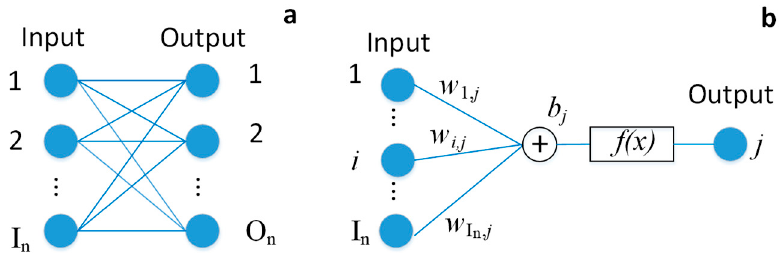
Figure 1. One layer of deep network. ( a ) Fully connected layer. All of the input elements are connected to each output element. ( b ) Obtaining j -th element of output from input elements.